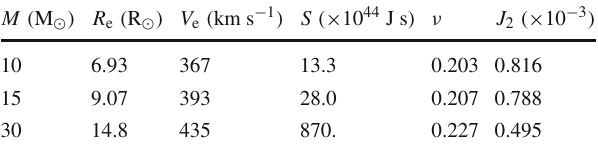
Table3 SameasinTable2butforESTERmodelsofstarsatmid-main- sequence, namely when the hydrogen mass fraction in the convective core is half of the initial one M ( M (cid:2) ) R e ( R (cid:2) ) V e ( km s − 1 ) S ( × 10 44 J s )